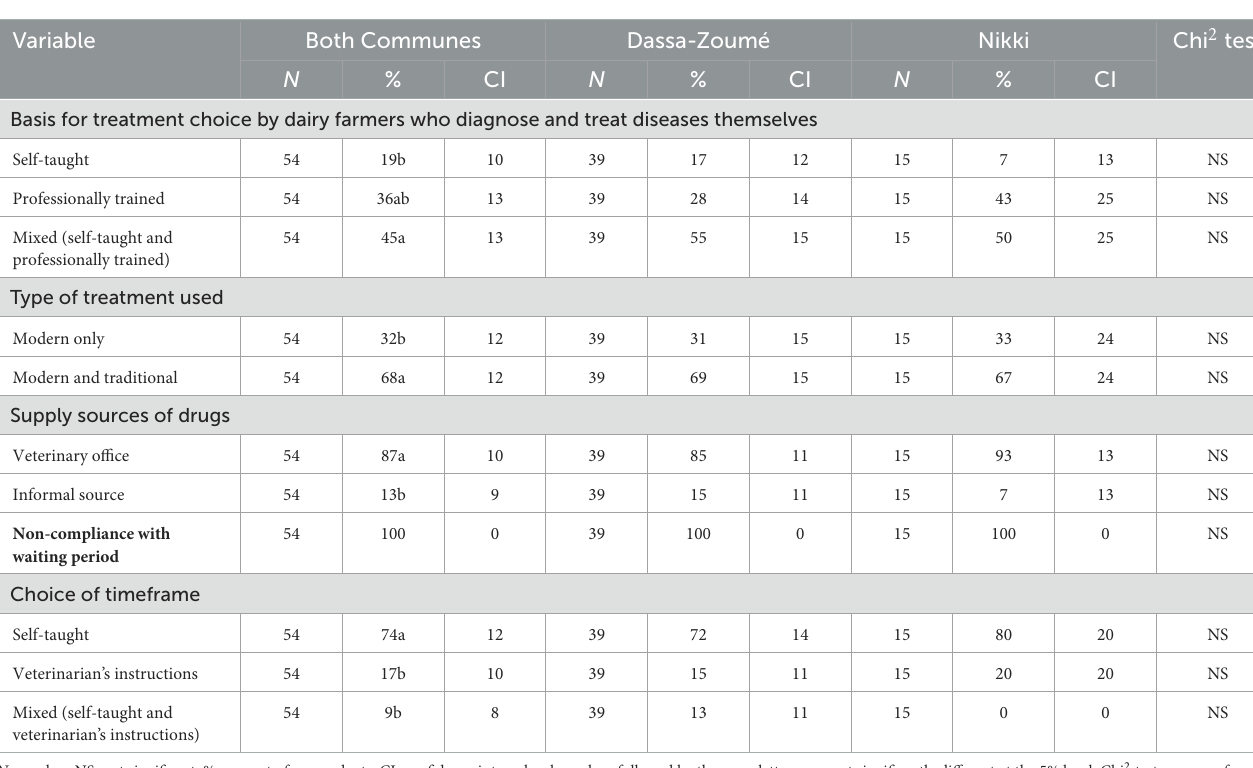
Other 73 Diagnosed and treated by who Dairy farmer Veterinarian